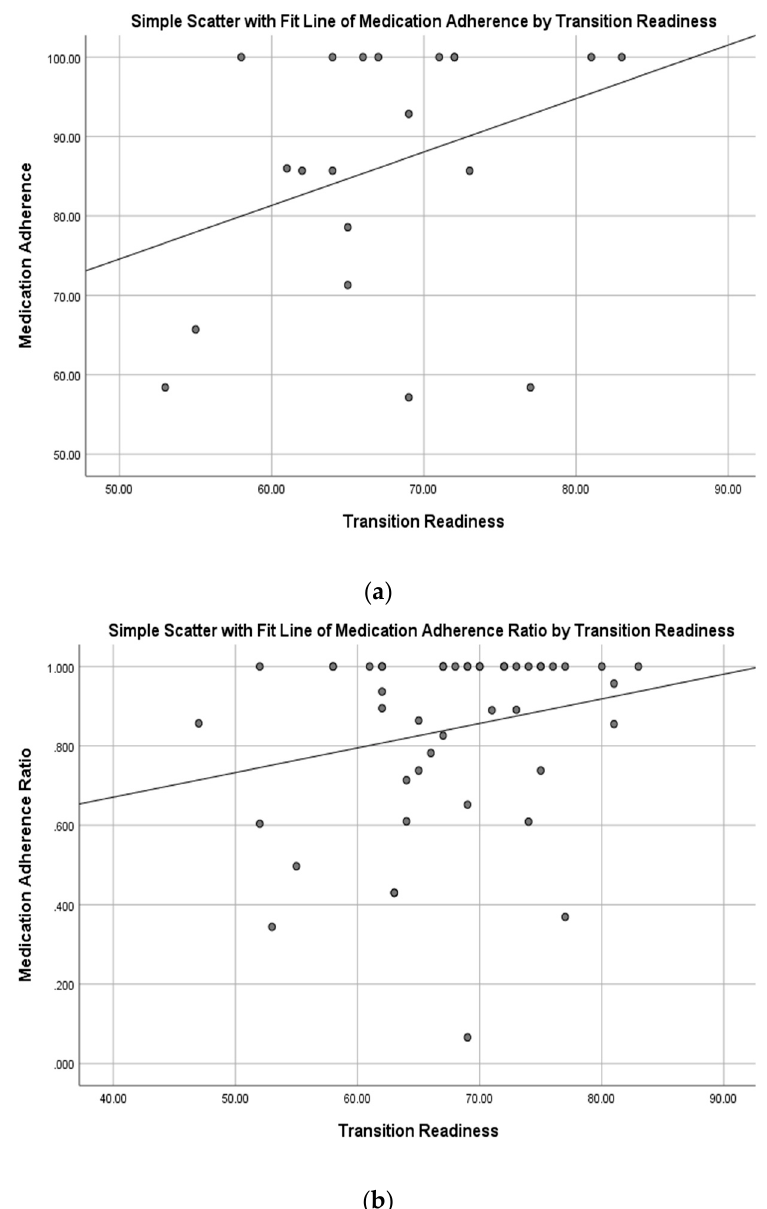
Figure 3. ( a ) Relationship between transition readiness and self ‐ reported medication adherence. ( b ) Relationship between transition readiness and medication adherence ratios.